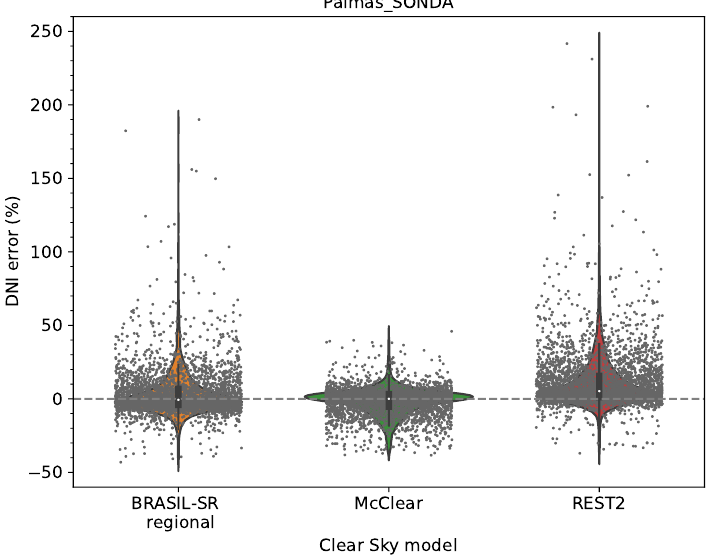
Figure 13. Combined violin and strip plots of the deviations of the BRASIL-SR regional experiment DNI without δ -Eddington scaling, McClear and REST2 for